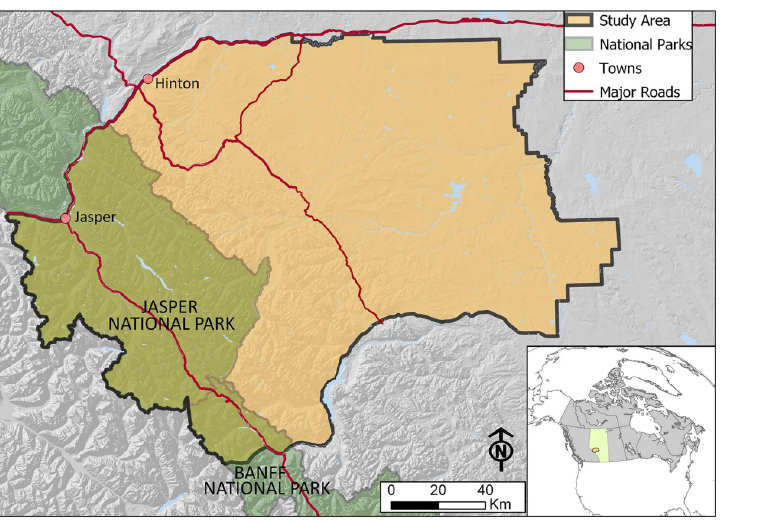
Fig 1. The Yellowhead bear management area (BMA3) in Western